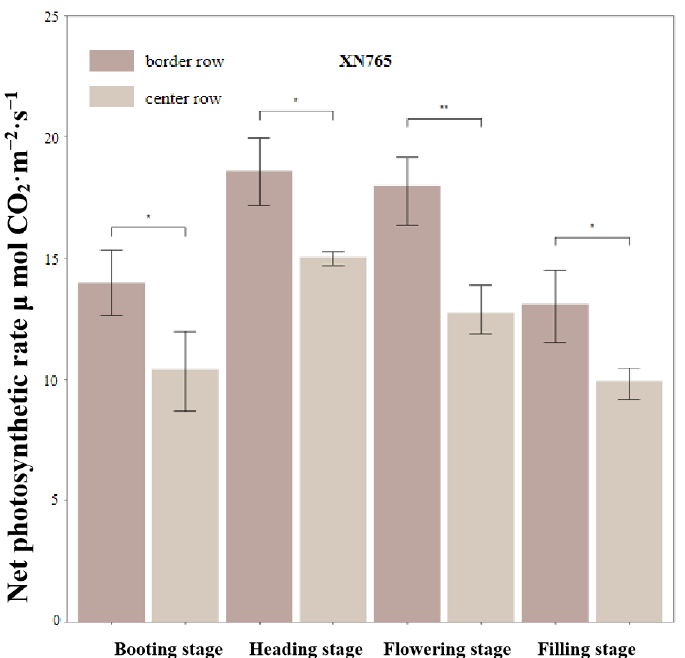
Figure 4. Border effect of net photosynthetic rate of wheat in different stages. (*: p ≤ 0.05, **: p ≤ 0.01, and NS: non-significant (ANOVA)).